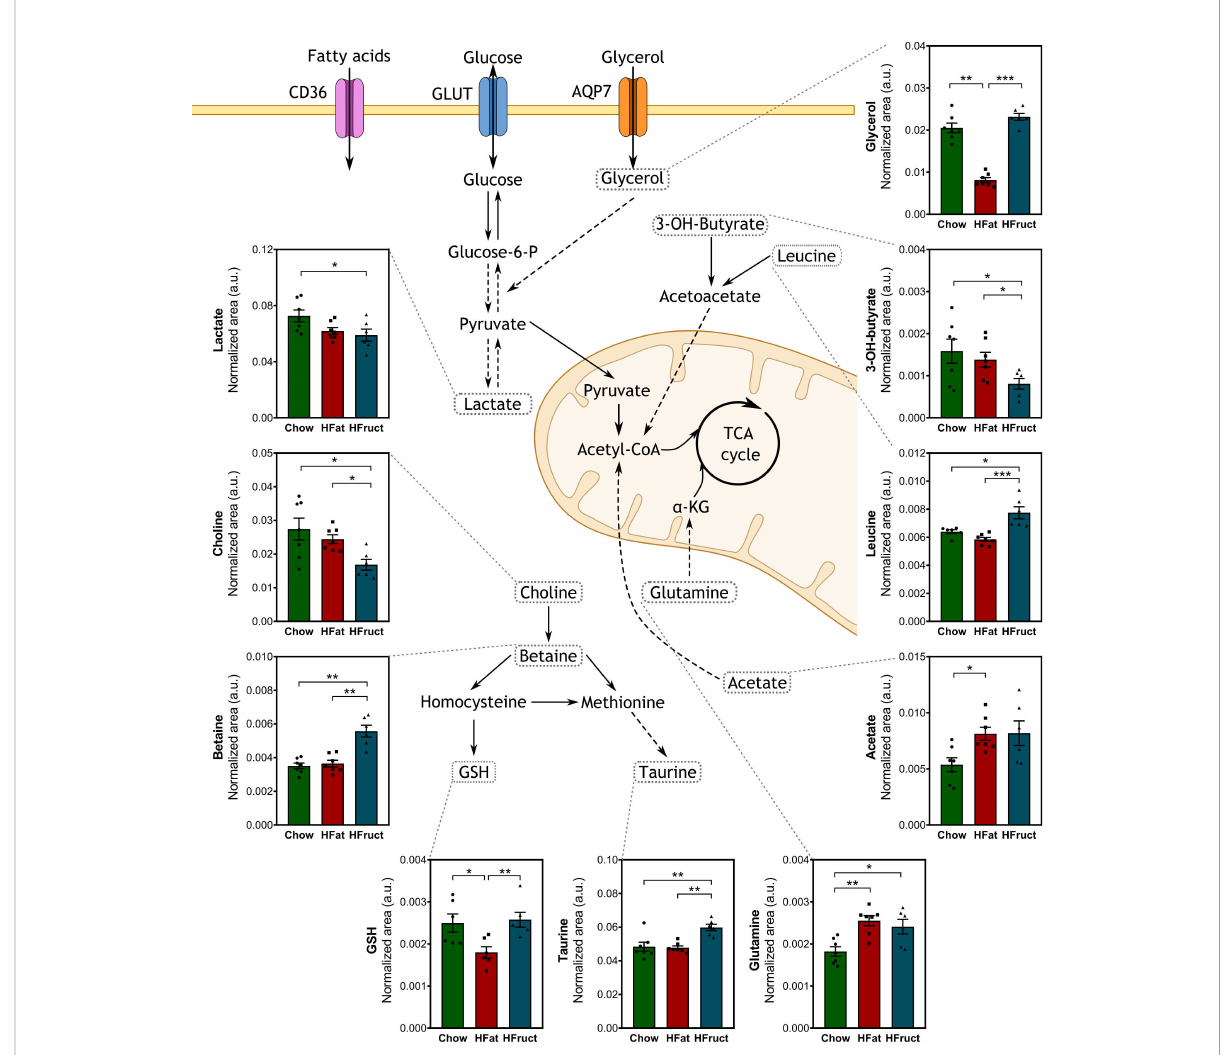
a -ketoglutarate; AQP7, aquaporin 7; CD36, cluster of differentiation 36; G6Pase, glucose-6-phosphatase; GK, glucokinase; GLUT, glucose transporter; GSH, glutathione; IMP, inosine monophosphate; TCA, tricarboxylic acid. Data are presented as mean ± SEM for fi ve to seven